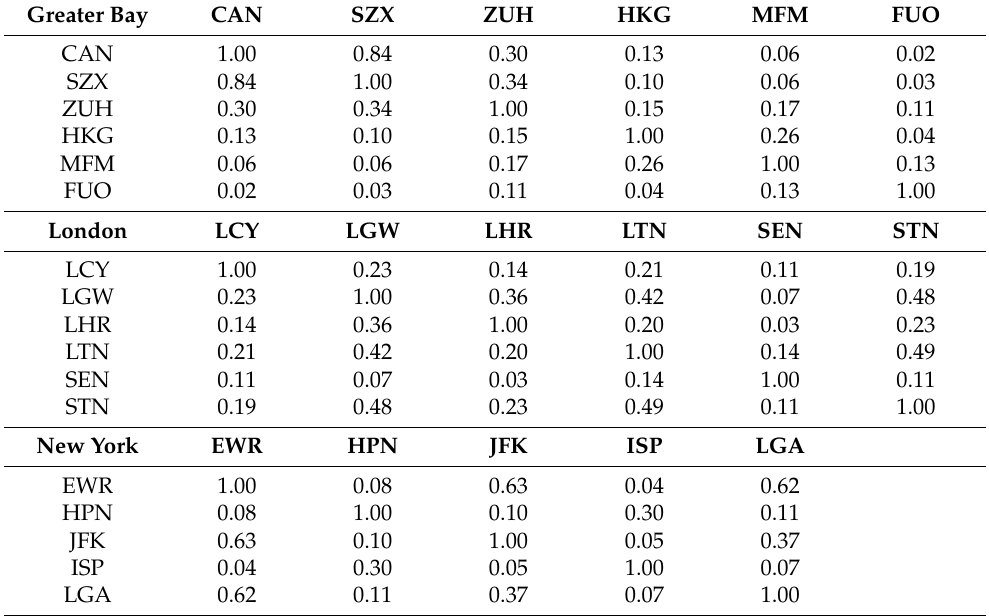
Table A4. Homogenization result of